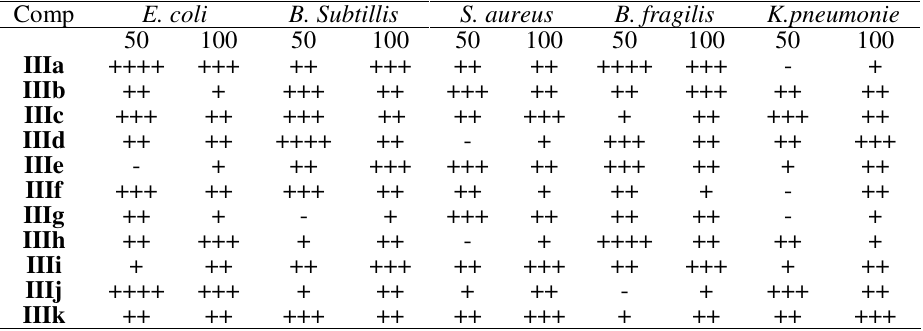
Table 3. Antibacterial activity of the synthesized III(a-k) against various bacteria at two different concentrations (ppm)